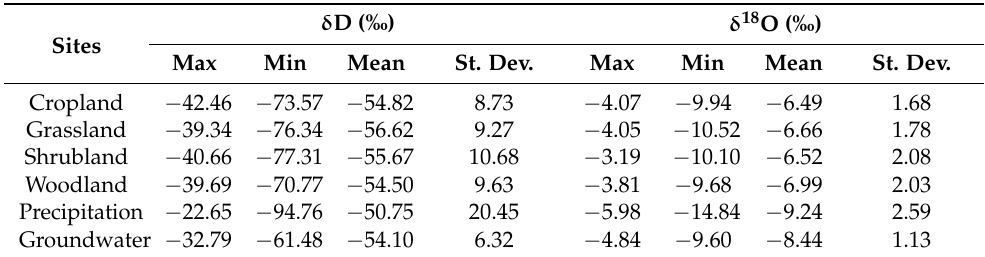
Table 1. Stable isotopic composition of soil water from four different land uses, precipitation, and